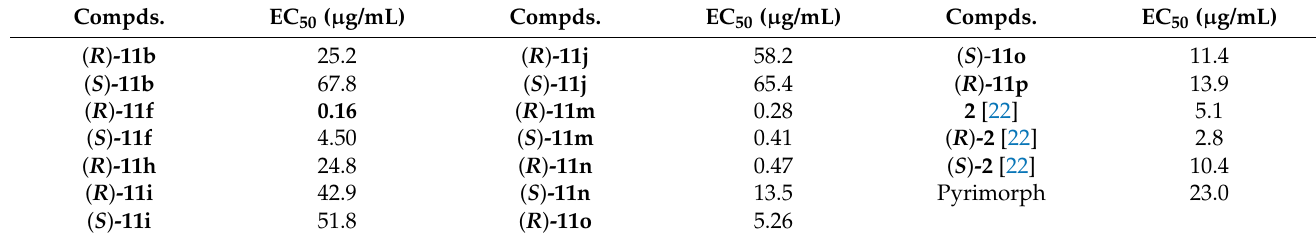
Table 2. The EC 50 values ( µ g/mL) of some compounds against S. sclerotiorum in the in vitro fungicidal activities.